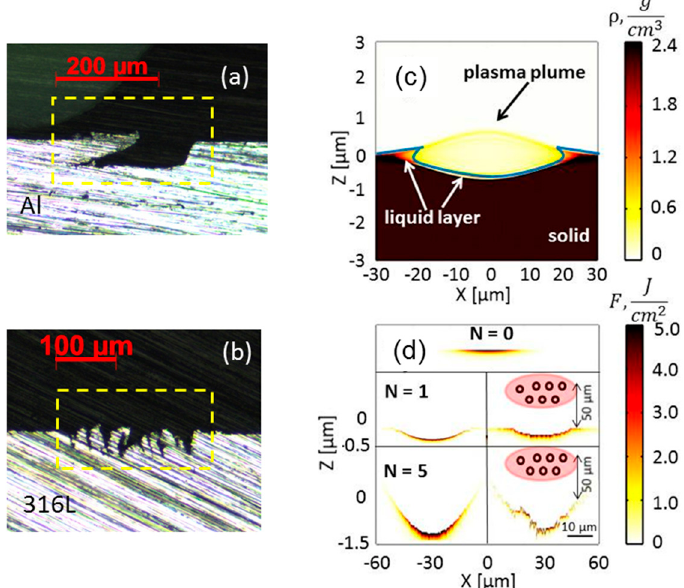
Figure 2. Cross-section images of laser processed ( a ) aluminum, and ( b ) stainless steel 316L, at a fluence of 18 J/cm 2 and pulse repetition rate of 250 kHz. The dashed line boxes are visual guides for highlighting the features inside the ablation grooves; ( c ) Density snapshot showing plasma plume expansion from aluminum surface 50 picoseconds after irradiation; ( d ) Multi-pulse simulations of energy deposition on stainless steel surface. Top row N = 0, initial surface; middle row N = one pulse; and bottom row N = five pulses. In the middle and bottom rows, unaffected (left) /affected (right) laser structuring by the presence of nanoparticles of r = 50 nm and concentration of C = 50 µm − 2 .